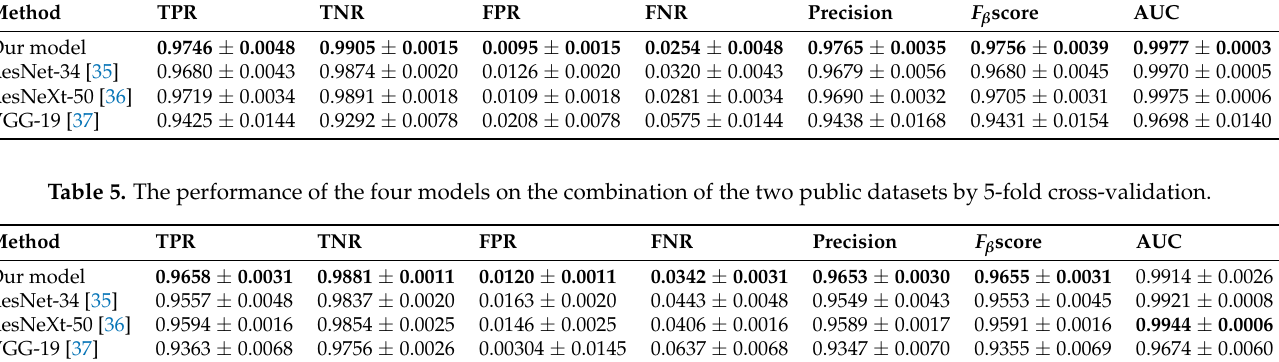
Table 4. The performance of the four models on the APL-Cytomorphology_LMU dataset by 5-fold cross-validation. Method TPR TNR FPR FNR Precision F β score AUC Our model